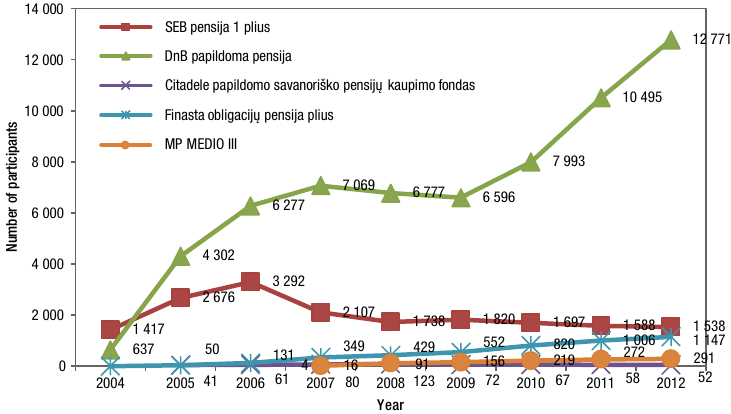
Fig. 3. The change of participants in bond and balanced 3 rd pillar PF during 2004–2012 Source : created by authors according to annual reports of